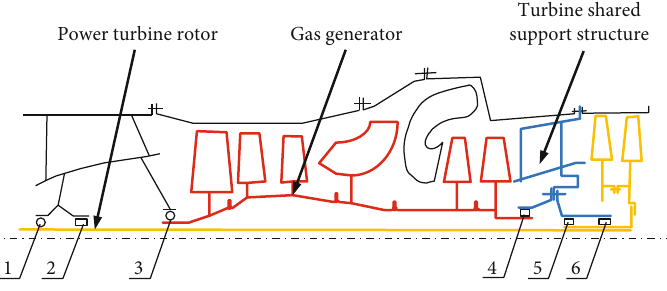
Figure 1: Structural diagram of turboshaft engine.